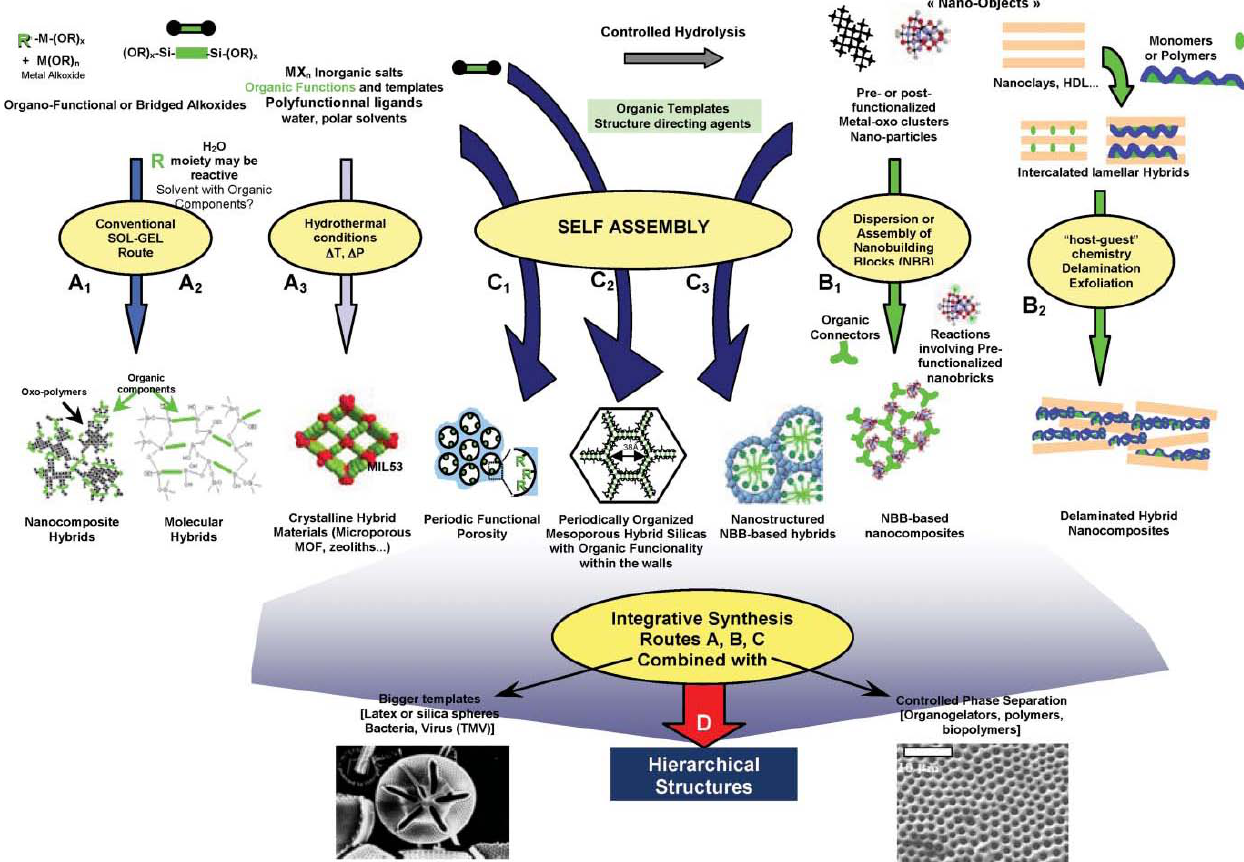
Figure 2. Schematic representation of the main chemical routes for the synthesis of polymer-inorganic nancomposites. Path A: sol-gel process; Path B: assembly or dispersion; Path C: self-assembly procedures; Path D: integrative synthesis. (adapted from